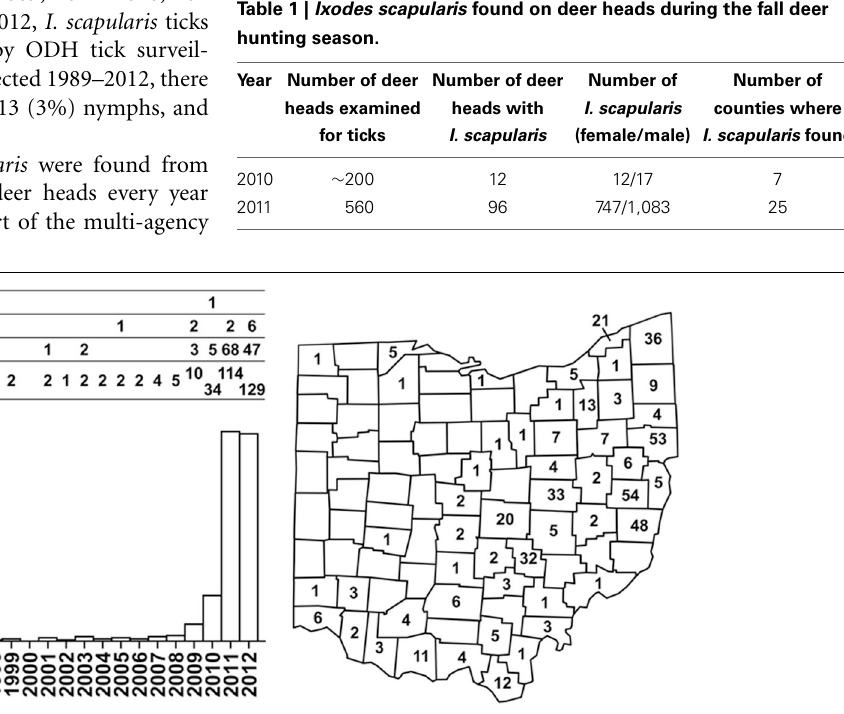
the ticks are indicated above the bar graph: L, larva; N, nymph; M, male, F, female. Cumulative numbers of I. scapularis found in Ohio counties are indicated on the